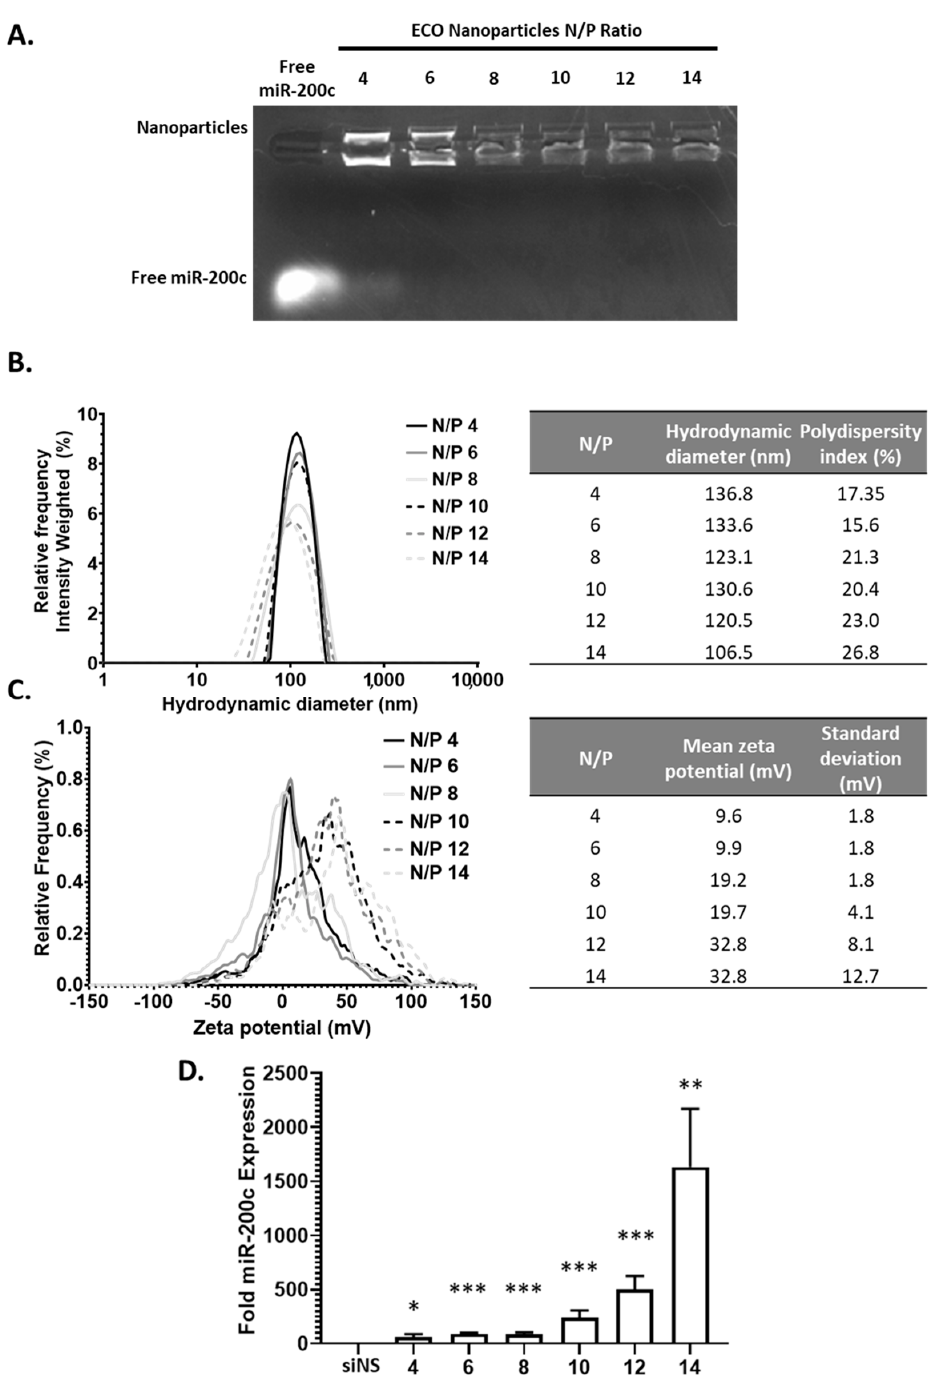
Figure 3. The ECO/miR-200c nanoparticle characterization and transfection. ( A ) The electrophoresis of ECO/miR-200c nanoparticles at N/P ratios 4–14. ( B , C ) The hydrodynamic diameter and zeta potential of the ECO/miR-200c nanoparticles. ( D ) The miR-200c levels after 48 h of ECO/miR-200c nanoparticles transfection in MDA-MB-231 cells. The bars indicate mean ± s.e.m. * p < 0.05, ** p < 0.01, and *** p < 0.005 using an unpaired t − test.